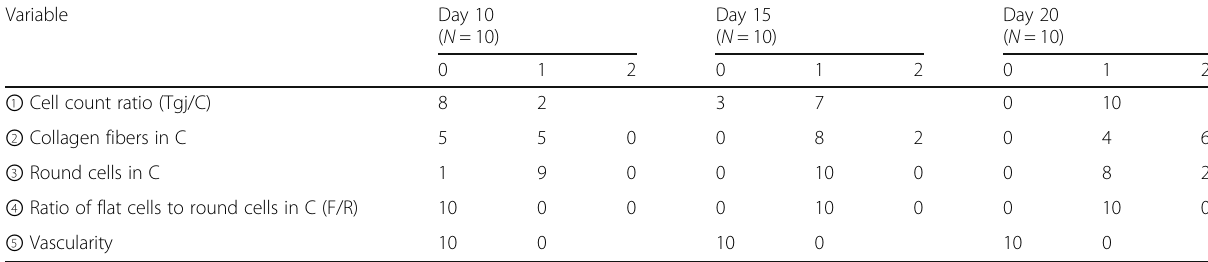
Table 3 Distribution of the tendon gel maturity score